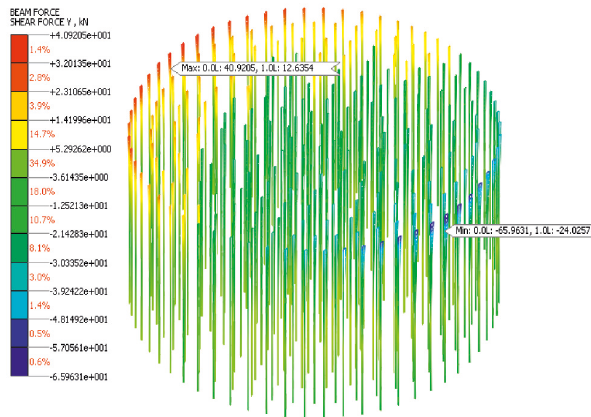
Figure 12: Shear force distribution diagram of pile group (maximum